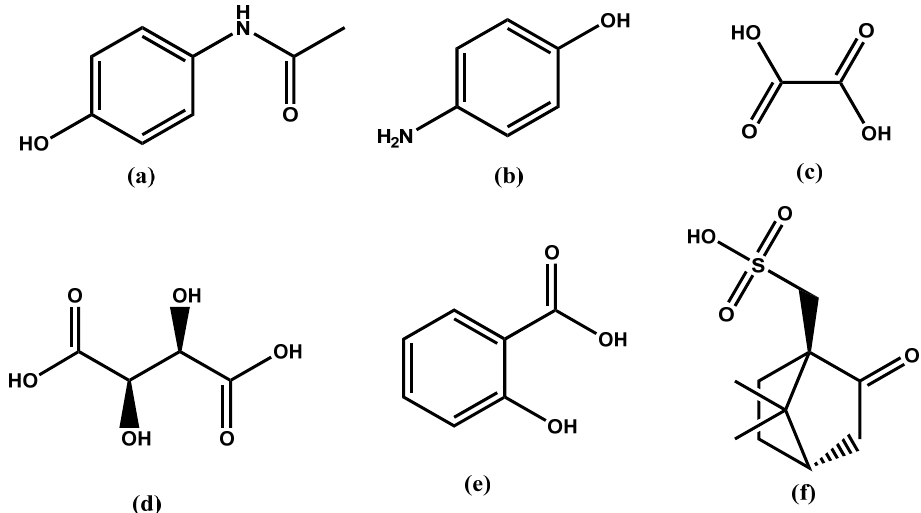
Figure 1. List of compounds used in this study: ( a ) paracetamol (PA), ( b ) p -aminophenol (PAP), ( c ) oxalic acid (OX), ( d ) L -tartaric acid (TA), ( e ) salicylic acid (SA), and ( f ) camphorsulfonic acid (CSA).